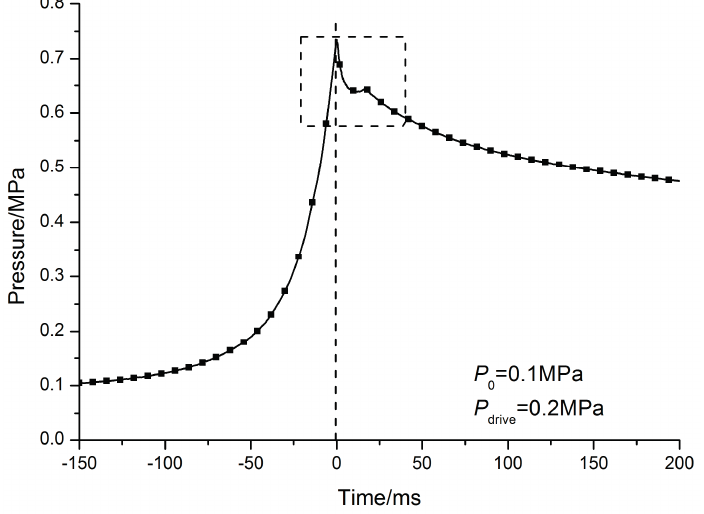
Figure 8. Typical pressure trace of nitrogen in the RCM without hydraulic